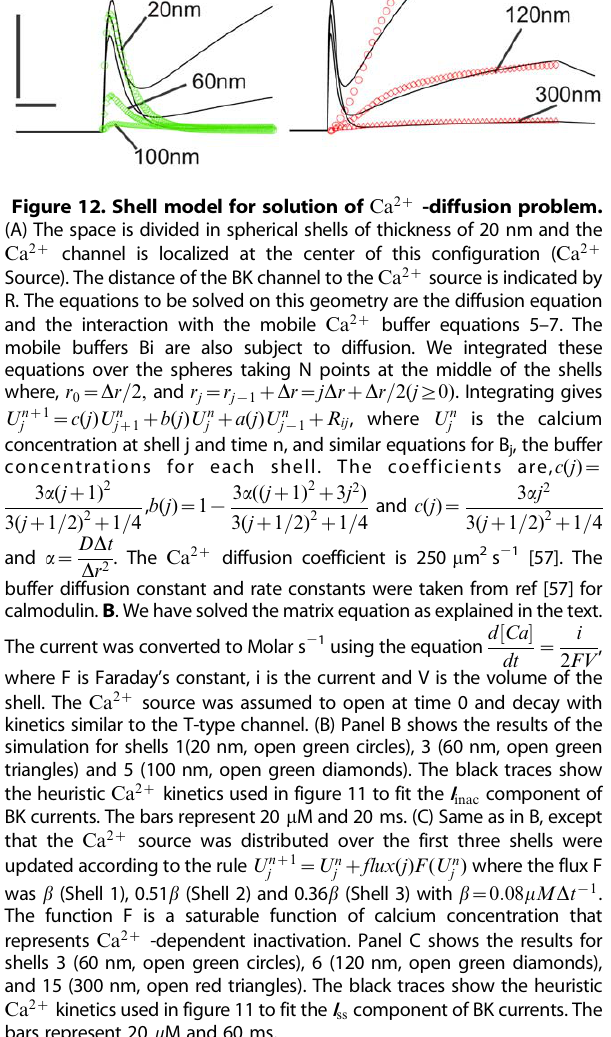
figure 11. Superimposed on this figure are the heuristic Ca 2 z kinetics used in figure 11 to generate the BK current kinetics. In